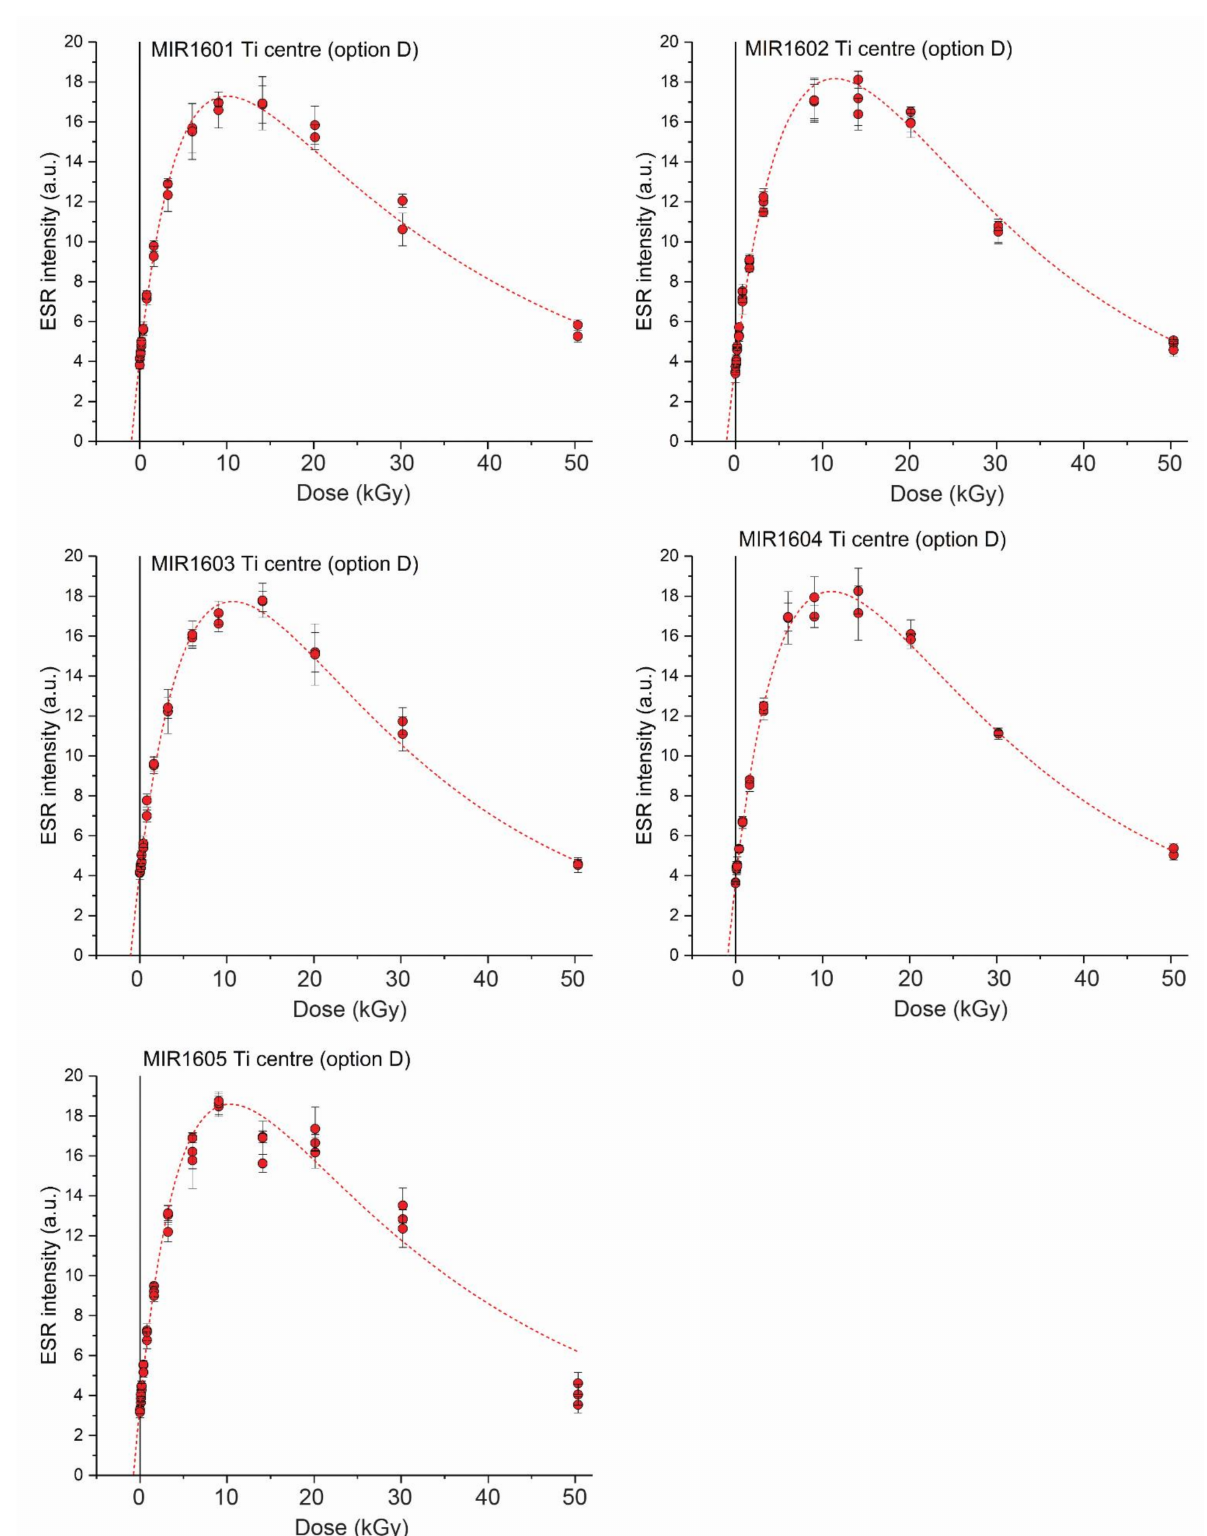
Figure 4. ESR dose response curves (DRCs) of Ti centers (option D) obtained for five samples dated in present work. All ESR intensities derived from repeated ESR measurements were pooled for fitting. Vertical error bars represent experimental errors associated with ESR intensities, corresponding to 1 standard